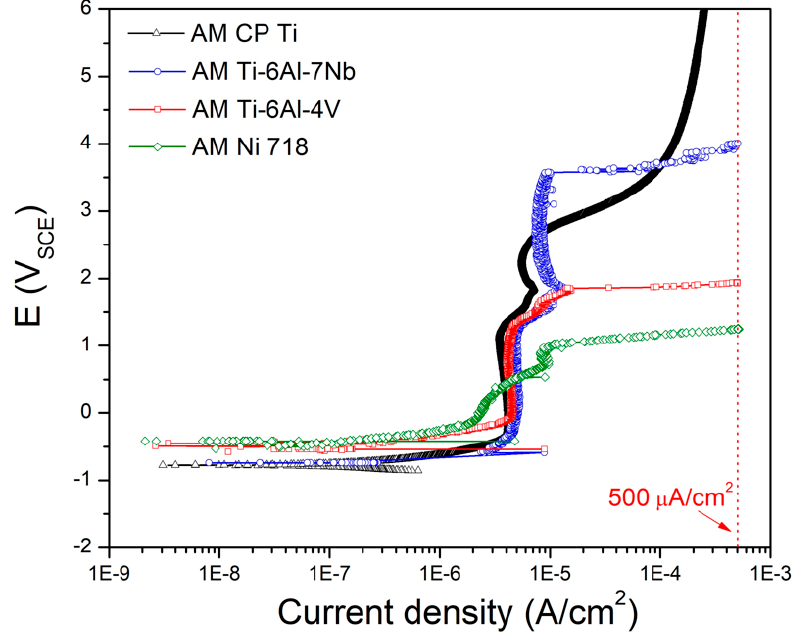
Figure 6. Potentiodynamic anodic curves of AM alloys such as CP Ti, Ti-6Al-7Nb, T-6Al-4V, and Ni 718. (Note 500 μ A/cm 2 is chosen as the suitable galvanostatic current density for galvanostatic mode.).